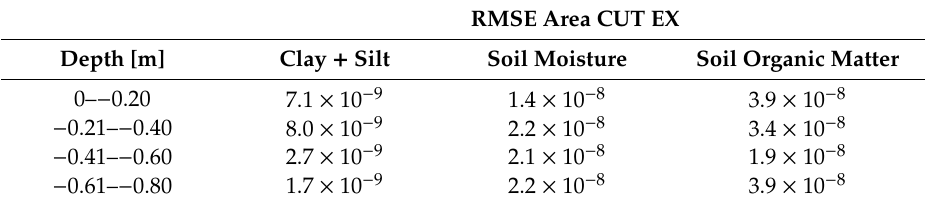
Table 11. Root mean square error (RMSE), interpolated raster datasets of CUT